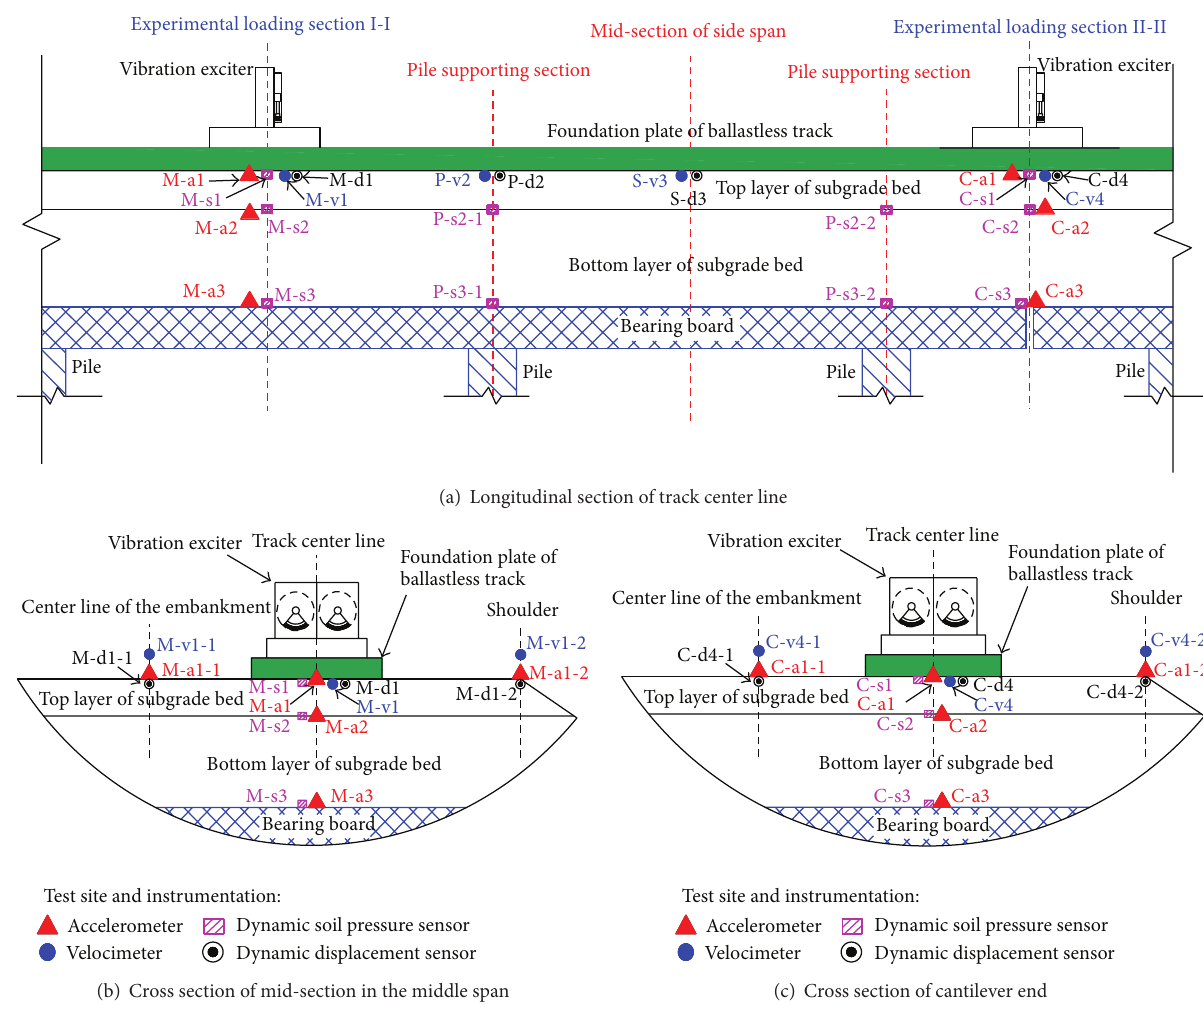
Figure 6: Test site and instrumentation.